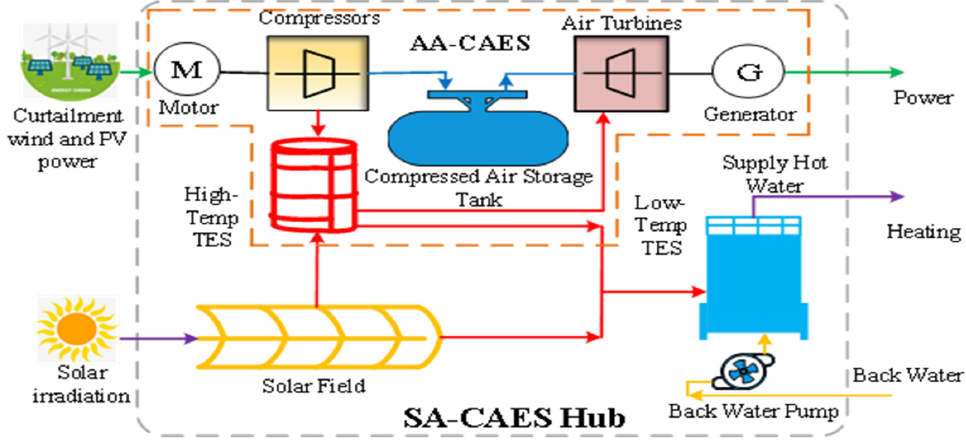
Figure 1. Flowchart of the SA-CAES hub.